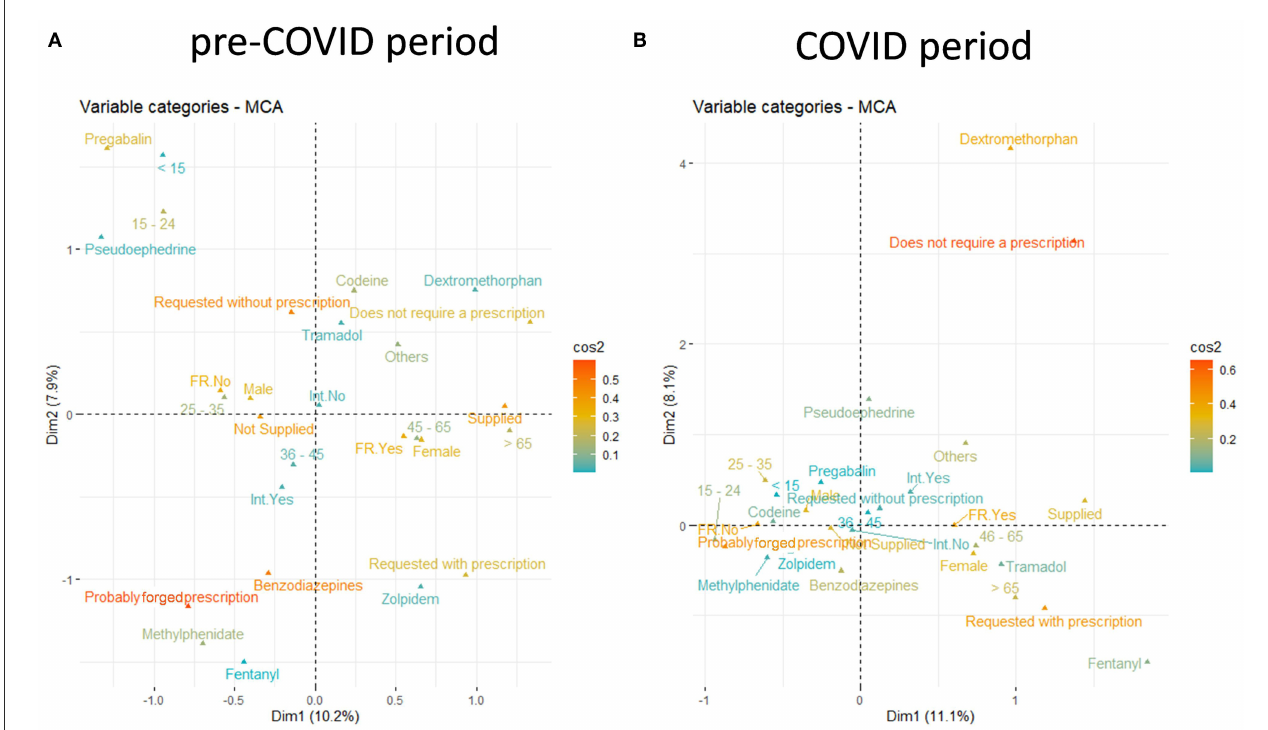
FIGURE1 Two-dimensional MCA plots for the pre-COVID period (A) and the COVID period ( B) . Cos2 measures the degree of association between variable categories and axial categories. If the variable category is well represented by the dimensions, values for cos2 are close to one.